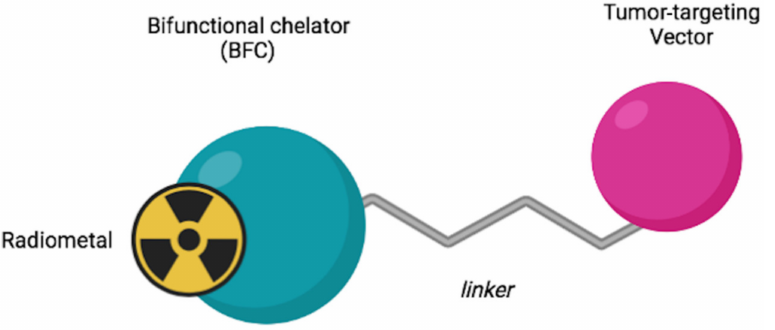
Figure 2. Structure of a radiopharmaceutical having a bifunctional chelator (BFC) incorporated within it.